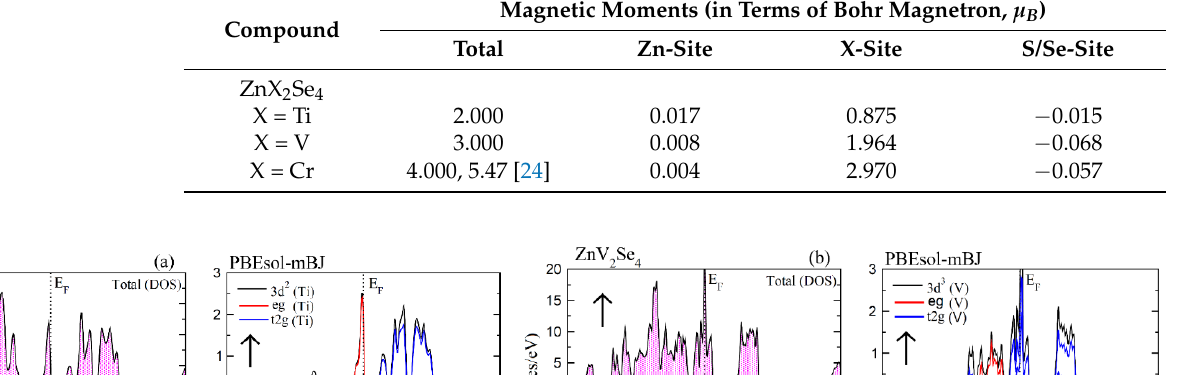
Table 3. The computed magnetic moment of whole composition and at Zn, X = Ti, V, Cr and Se sites of ZnX 2 Se 4 (X = Ti, V, Cr).